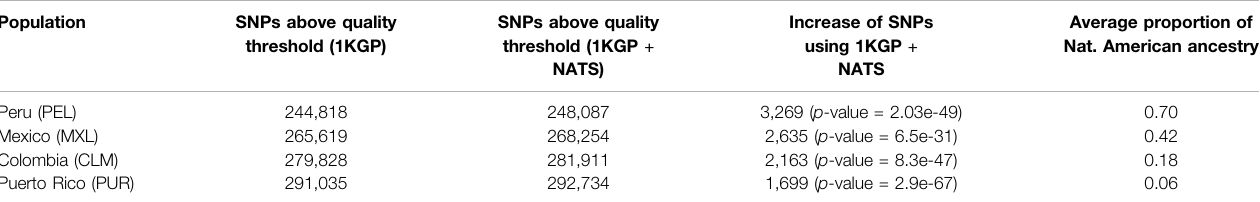
TABLE 1| SNPsabove thestandardquality thresholdusing bothpanelsafterimputingmissingvariants.WeshowtheaveragenumberofSNPswithMAF > (cid:1) 0.01andINFO > (cid:1) 0.3 using both reference panels and the overall proportion of Native American ancestry of the population. p -value was calculated with a two-tailed paired t -test. The average number of SNPs with MAF < 0.01 and INFO > 0.3 for both panels is shown in Supplementary Table S4